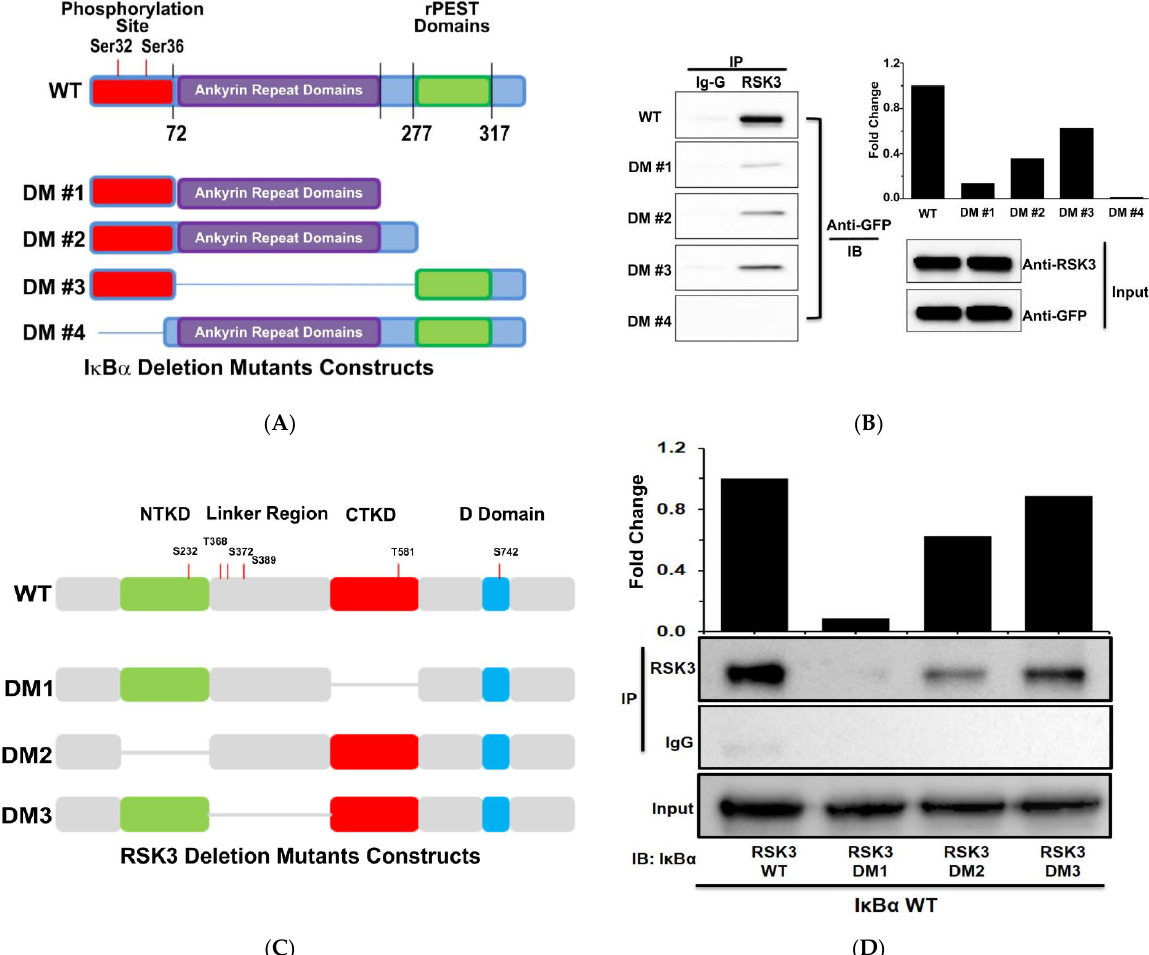
Figure 3: Figure 2. The CTKD domain of RSK3 binds to the N-terminus of I κ B α . ( A ) Schematics of full-length and deletion mutants (DMs) of I κ B α . ( B ) Full-length Myc/His-RSK3 and WT pAC-GFP-I κ B α WT or DM#1–4 were co-transfected into HEK293T cells. RSK3 was immunoprecipitated, and co-immunoprecipitated I κ B α was identified by Western blotting using an anti-GFP antibody. Representative results from two experiments are shown. ( C ) Schematics of full-length and DMs of RSK3. ( D ) Full-length WT Myc/His-I κ B α and pAC-GFP-RSK3 WT or DM1–3 were co-transfected into HEK293T cells. RSK3 was immunoprecipitated, and co-immunoprecipitated I κ B α was detected by Western blotting with an anti-I κ B α antibody. Representative results from three experiments are shown. (** p < 0.01 and * p < 0.05 vs. WT